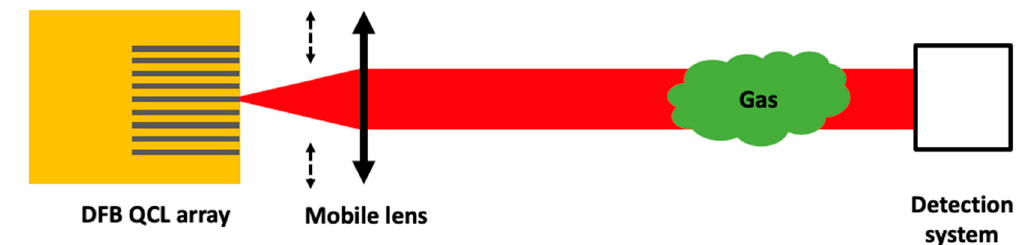
Figure 1. Schematic of a DFB QCL array source for gas detection. Grey lines in the yellow square indicate the lasers in the array. A mobile lens following the dashed arrows must be moved to adapt to the output of the chosen laser.